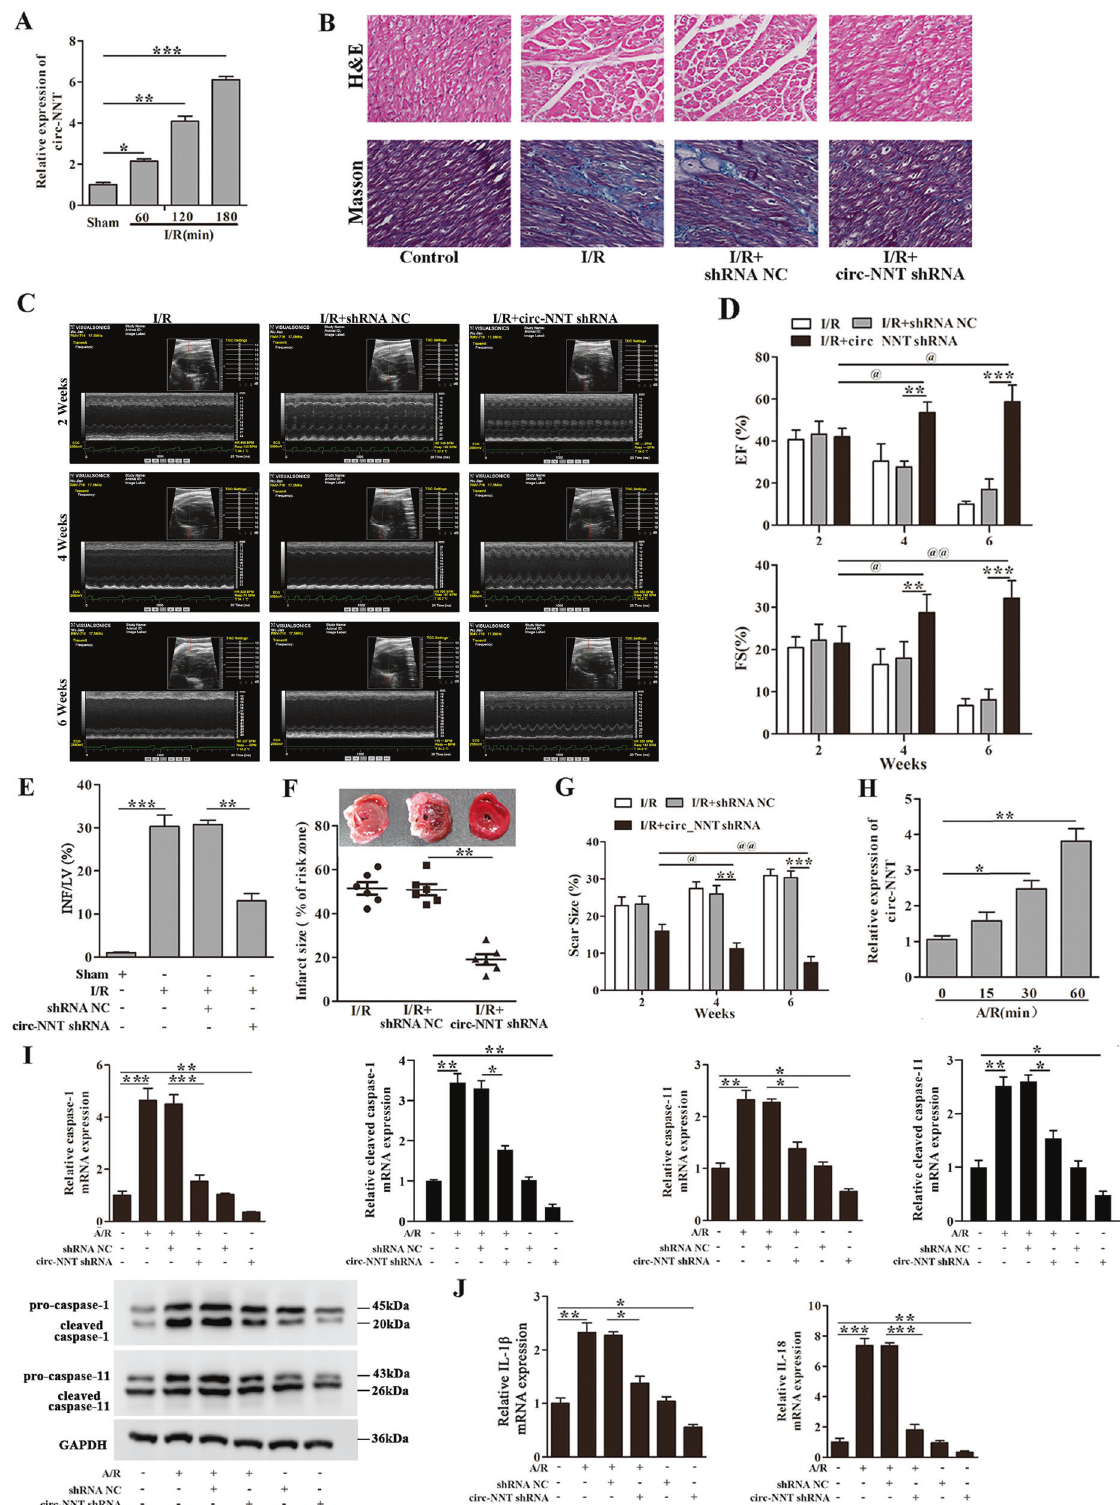
revealed by H&E and Masson trichrome staining (Fig. 3B). The results demonstrate that these I/R-induced abnormalities were attenuated by circ-NNT knockdown. At 2, 4 and 6 weeks post I/R, the mice exhibited a pronounced decline in LV function, re fl ected